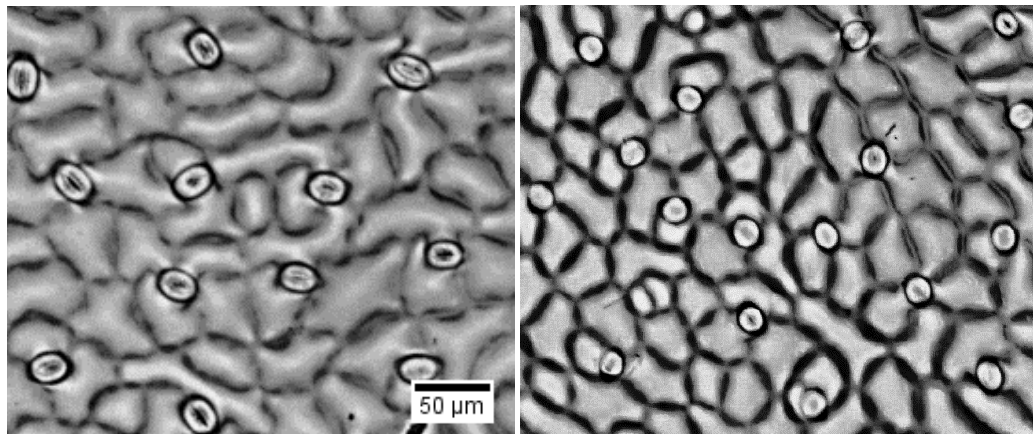
Figure 3. Stomatal density and size in the abaxial leaf surface of sugar beet plants grown under control (A) and saline (300 mM NaCl for 3 weeks) conditions. One (of 8-12) typical images is shown for each